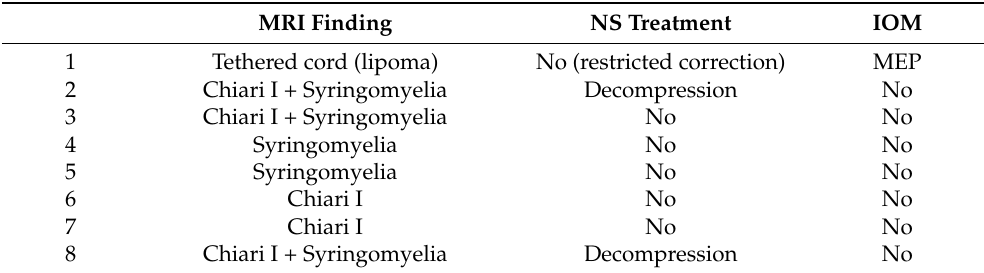
Table 1. MRI findings in conjunction with neurosurgical (NS) treatment prior to scoliosis surgery and IOM